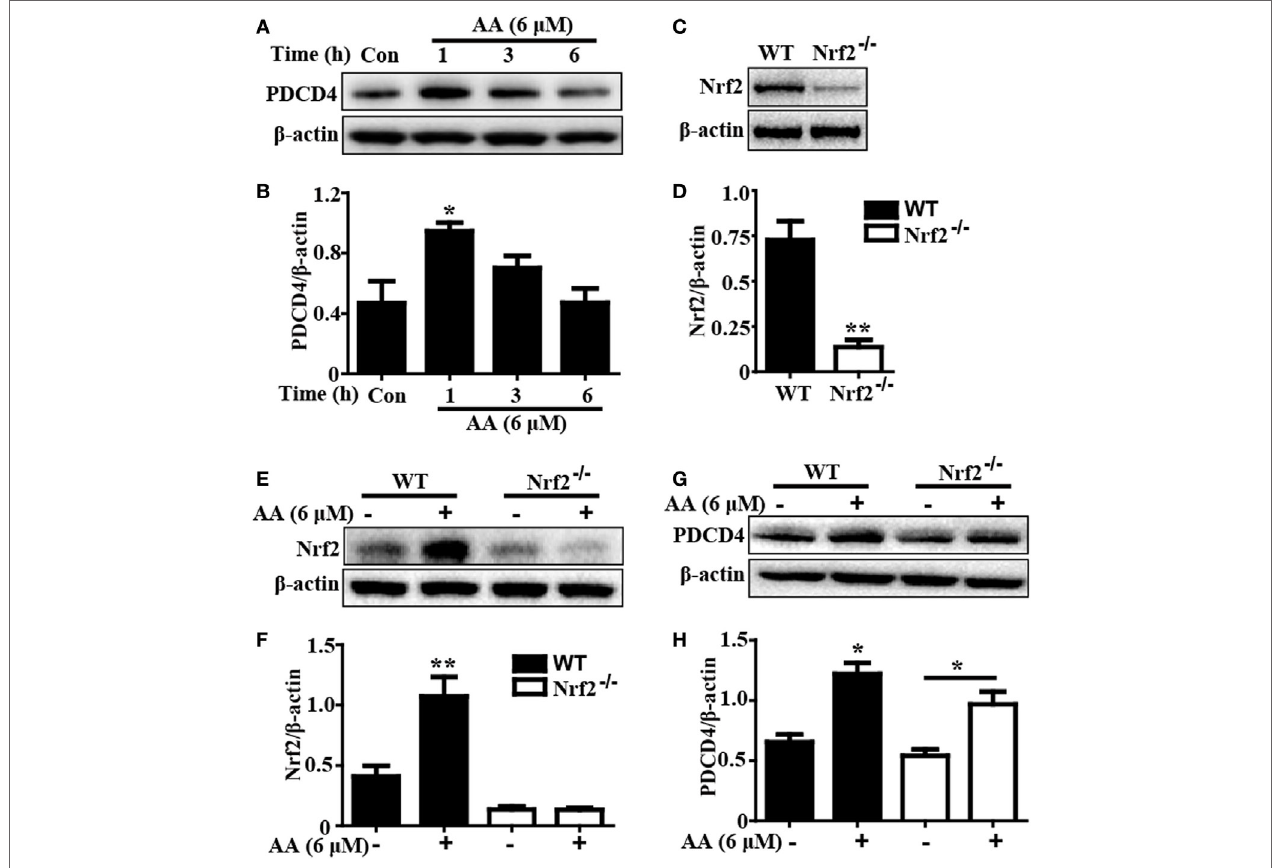
FigUre 6 | Asiatic acid (AA)-induced PDCD4 protein expression is independent upon Nrf2 activation in HepG2 cells. (a) HepG2 cells were pretreated with or without AA (6 µM) for 1, 3, or 6 h. Effects of AA on PDCD4 protein expression were measured by Western blotting analysis. Additionally, (c,e) WT and Nrf2 − / − HepG2 cells were pretreated with or without AA (6 µM) for 6 h. Effects of AA on Nrf2 protein expression were measured by Western blotting analysis. (g) WT and Nrf2 − / − HepG2 cells were pretreated with or without AA (6 µM) for 1 h. Effects of AA on PDCD4 protein expression were measured by Western blotting analysis. (B,D,F,h) Quantification of relative protein expression was performed by densitometric analysis and β -actin was acted used as an internal control. Similar results were obtained from three independent experiments. All data are presented as means ± SEM ( n = 5 in each group). * p < 0.05 and ** p < 0.01 vs. control